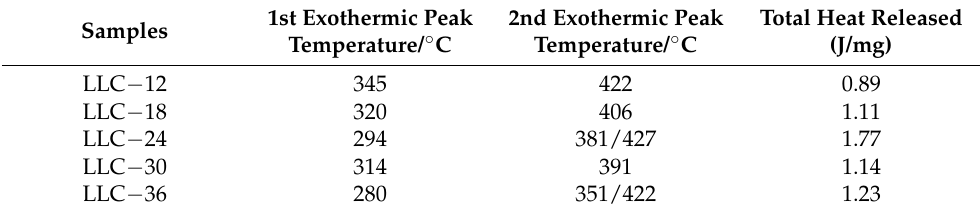
Figure 7. DSC results of all delithiated LLCs electrodes. Table 4. Summary of the peak temperatures and heat generated.